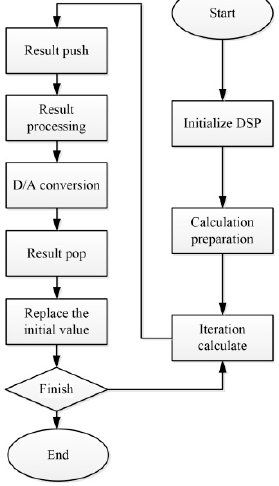
Figure 15. Programming flow of DSP implementation.